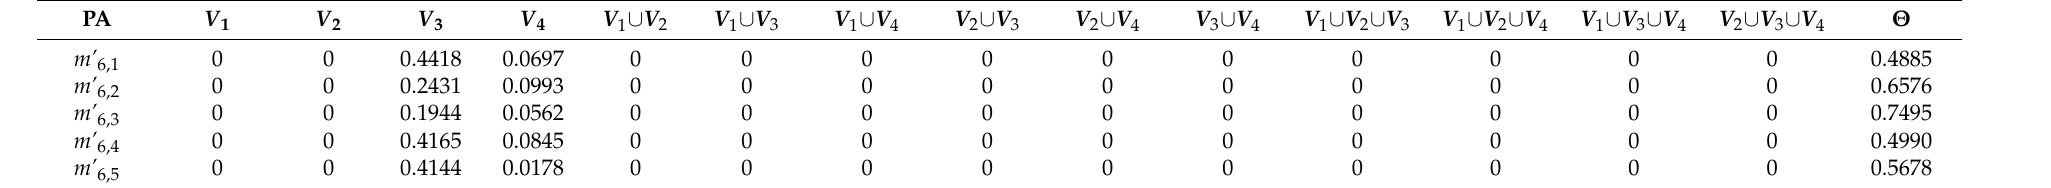
Table 16. Probability assignments of transverse crack-oblique crack sub-classifier for an image of a transverse crack.